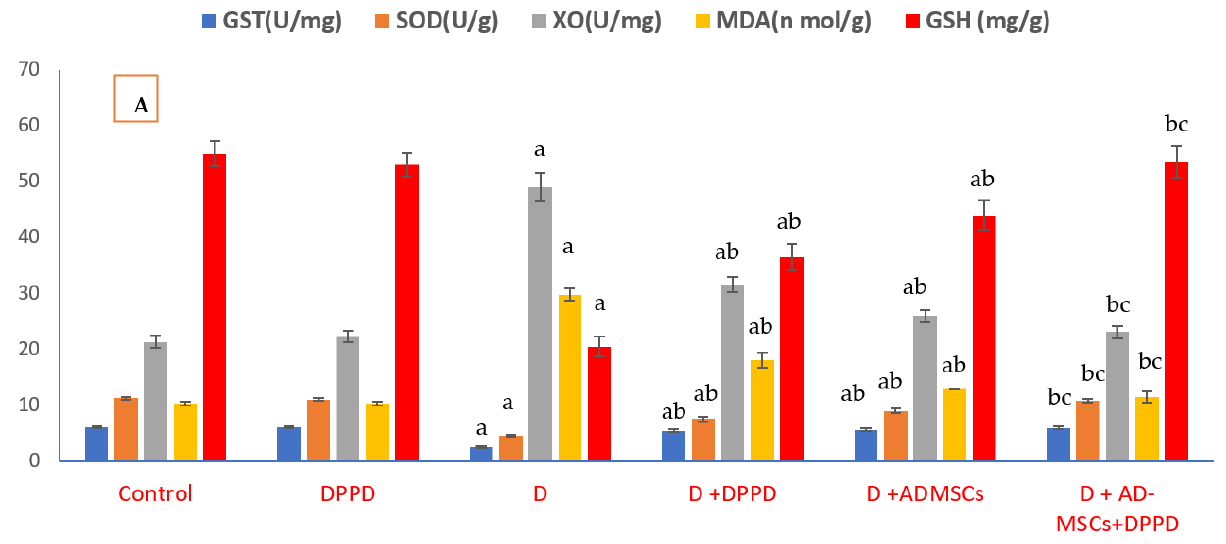
the diabetic group when compared to the control rats. Additionally, diabetic rats treated with either DPPD or AD ‐ MSCs or both combinations reflected significant oxidative mark ‐ ers decrease. In contrast, critical antioxidant markers increase in the diabetic group. Re ‐ sults of diabetic rats treated with AD ‐ MSCs+DPPD recorded a tremendous antioxidant AD-MSCs treatment alone in diabetic rats. potentiality to other treatments.